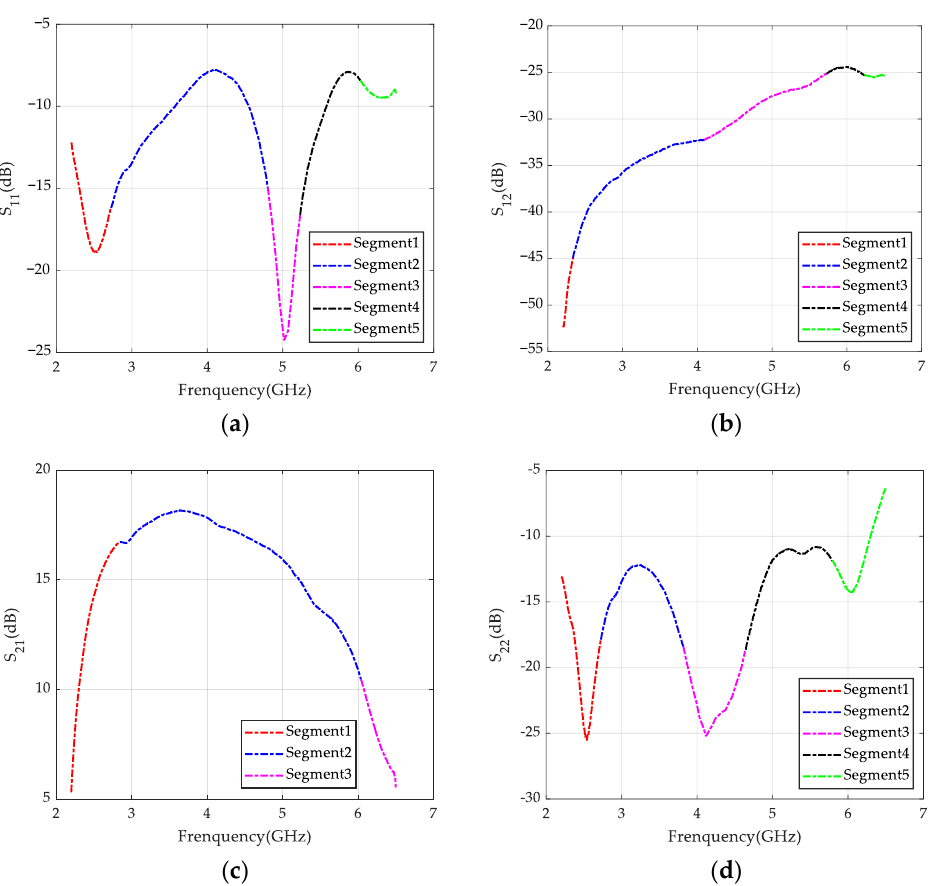
Figure 5. Results of splitting algorithm processing on S -parameters. ( a ) Piecewise curves of S 11 parameters. ( b ) Piecewise curves of S 12 parameters. ( c ) Piecewise curves of S 21 parameters. ( d ) Piecewise curves of S 22 parameters.